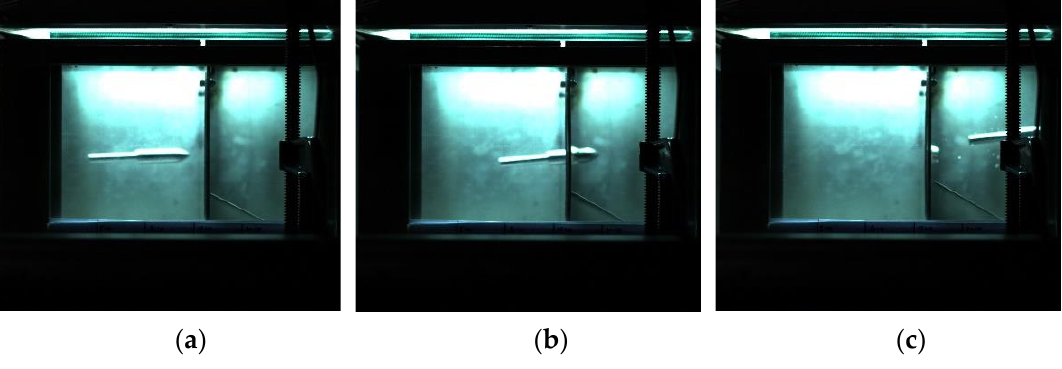
Figure 13. Experimental results for the launch speed of 56 m/s: ( a ) before penetration; ( b ) penetrating; ( c ) after penetration.